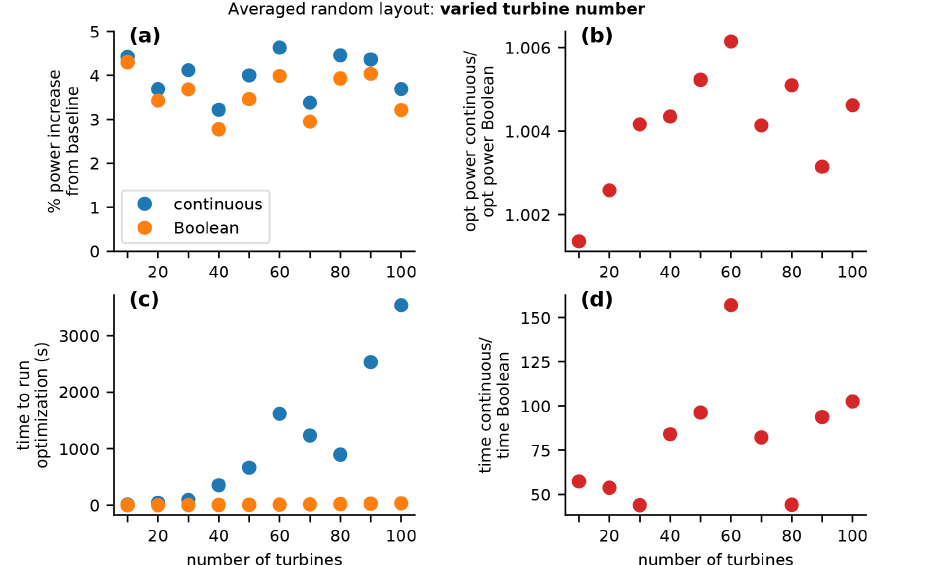
Figure 10. Comparison of a wind plant optimized with a traditional continuous approach compared to our novel Boolean optimization. The results in this figure are the averaged results for seven randomly generated wind turbine layouts for plants with different numbers of turbines. For the purposes of this figure, the average spacing was constant at 5 rotor diameters, while each panel shows different metrics as a function of the number of wind turbines. (a) The absolute percent increase in power over the nonyawed baseline for the continuous and Boolean optimizations. (b) The ratio of the optimized power with the continuous approach to the optimized power with the Boolean approach. (c) The absolute time required to run each optimization, again for the continuous and Boolean optimizations. (d) The ratio of the time required to optimize with the continuous approach to the time required to optimize with the Boolean